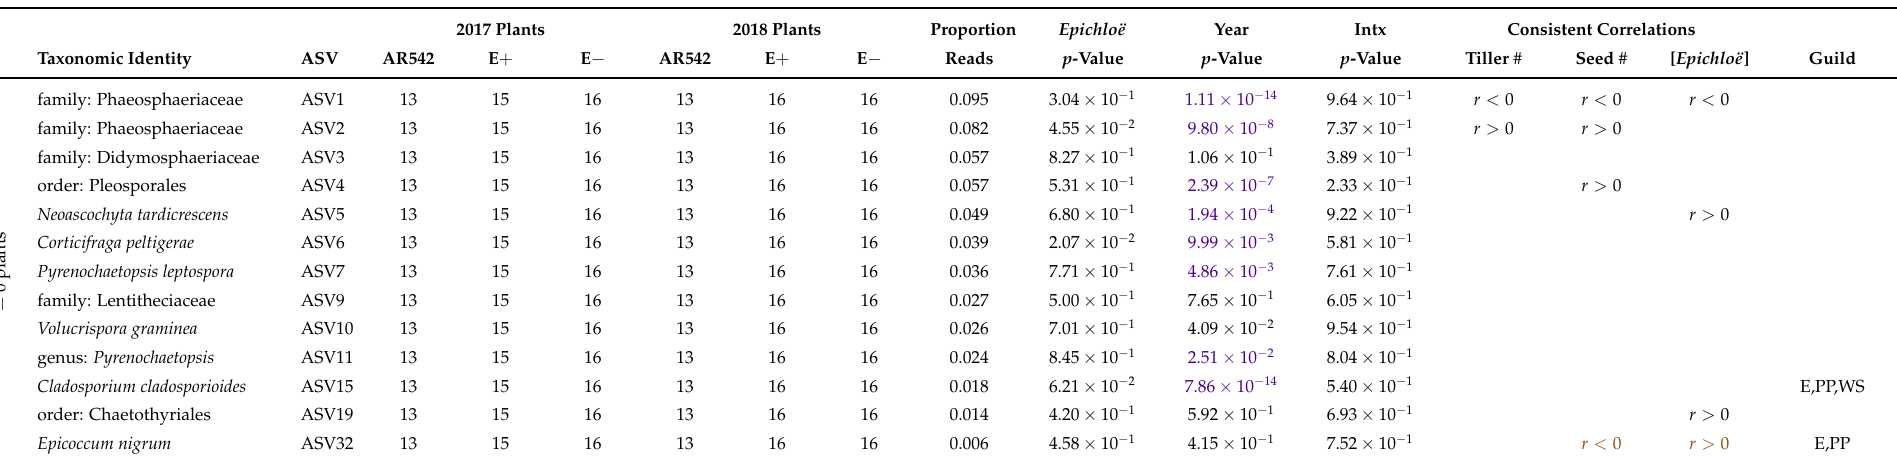
Table 4. Amplicon Sequence Variants (ASVs) that may comprise the core microbiome. Note that taxonomic assignments at the species level are only tentative; see Section 4.5. In the Epichloë treatment columns, the number of plants containing the ASV are shown. The maximum number of plants that may harbour an ASV are: AR542: N = 13, E − : N = 15 in 2017 and N = 16 in 2018, E + : N = 16. The deeper red shading indicates more plants are missing the ASV. ASVs are grouped by the maximum number of plants that are missing that particular ASV, from zero—i.e., the ASV is present in all plants and in both years—to five, where the ASV is missing from five or fewer plants in at least one Epichloë treatment × year combination. The three columns showing p -values are from a repeated measures ANOVA conducted on the number of reads (Intx denotes the interaction of Epichloë and year). Values in purple denote that the p -values are below the Benjamini–Hochberg Procedure critical value for controlling False Discovery Rate. Missing entries in the p -value columns indicate that the data could not be adequately transformed to meet the assumptions of the test. Note that these 43 ASVs account for 69% of all reads across both years. Consistent correlations denote ASVs that have consistent correlations (positive or negative) across all Epichloë treatments and years. For tiller and seed numbers, r < 0 suggest these ASVs are plant antagonists, and r > 0 suggest the ASVs are beneficial to the plant. For the Epichloë concentrations, r < 0 suggest a antagonistic relationship while values of r > 0 suggest a mutualistic relationship. ASVs denoted in brown are thought to be plant pathogens (see Guild column). For guild information from Fungal Traits [50], E denotes endophyte, PP denotes plant pathogen, AP denotes animal pathogen, and WS denotes wood saprophyte. For those ASVs identified to genus level, that did not match anything in FungalTraits database, we searched the CABI Invasive Species Compendium [51]. From this database, gpp denotes the genus contains plant pathogens (in this case Parastagonospora ), and pp denotes plant